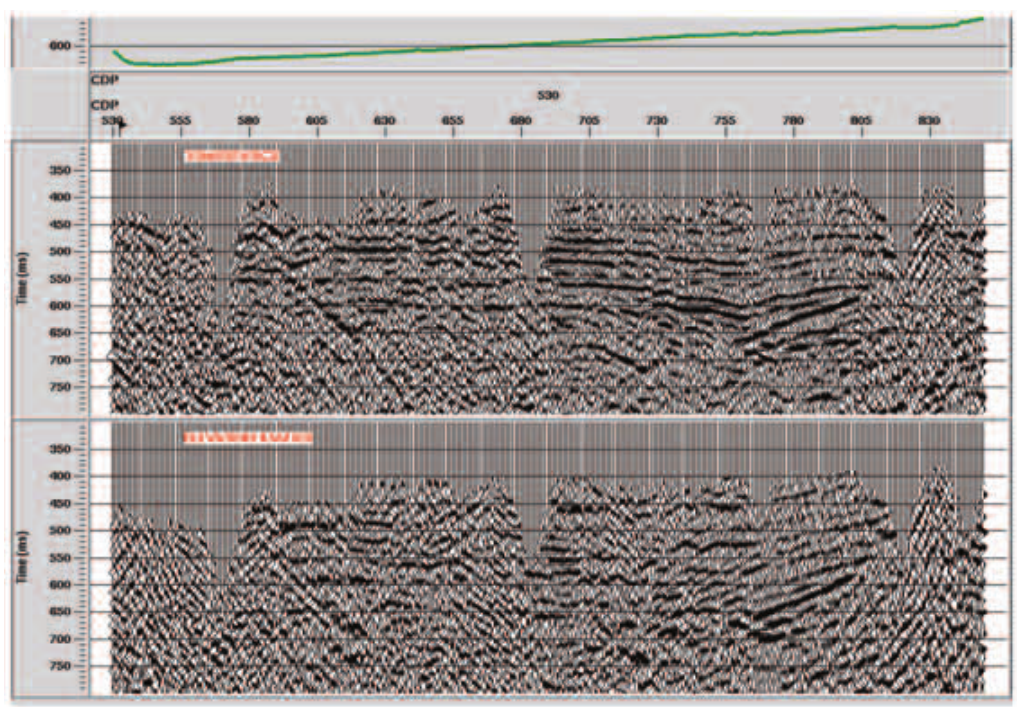
Fig. 7. Two Way Time (TWT) image of the Val d’Agri valley using tomostatics or elevation statics